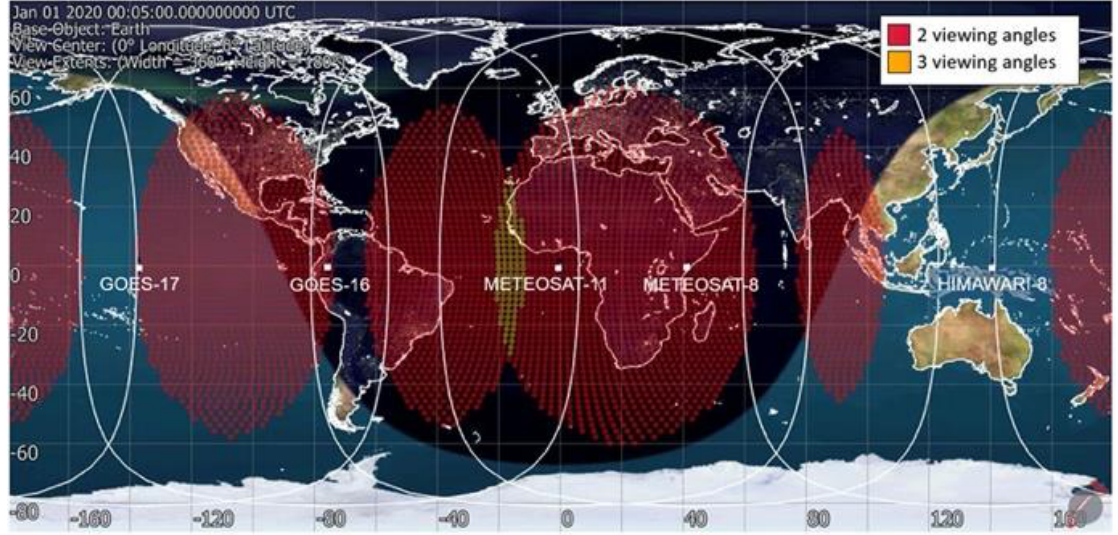
Figure 14. Sub 2 km resolution overlap of Meteosat-11, Meteosat-8, Himawari-8, GOES-16 and GOES-17, defining stereo- scopic availability.